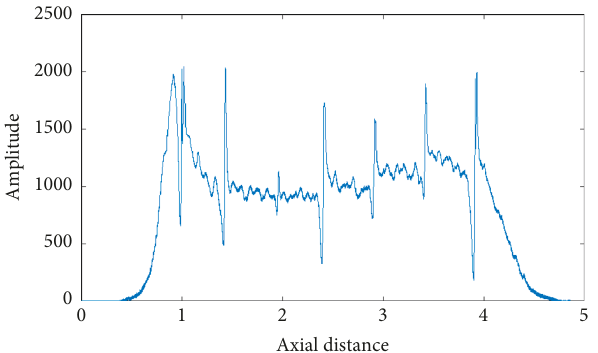
Figure 7: The original MFL data of single channel.